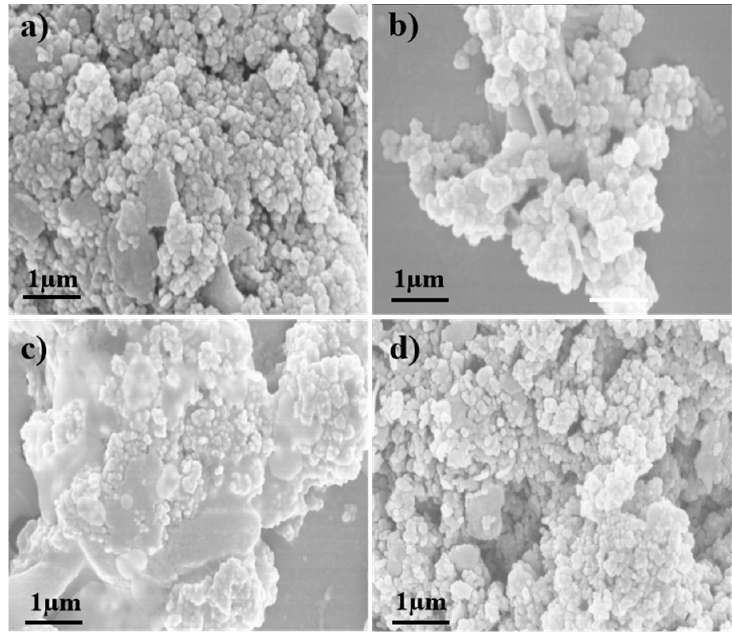
Figure 5. SEM images of the catalysts: ( a )V-W/Ti; ( b )Mn-V-W/Ti-P; ( c )Mn-V-W/Ti-I; ( d )Mn-V-W/Ti- S .